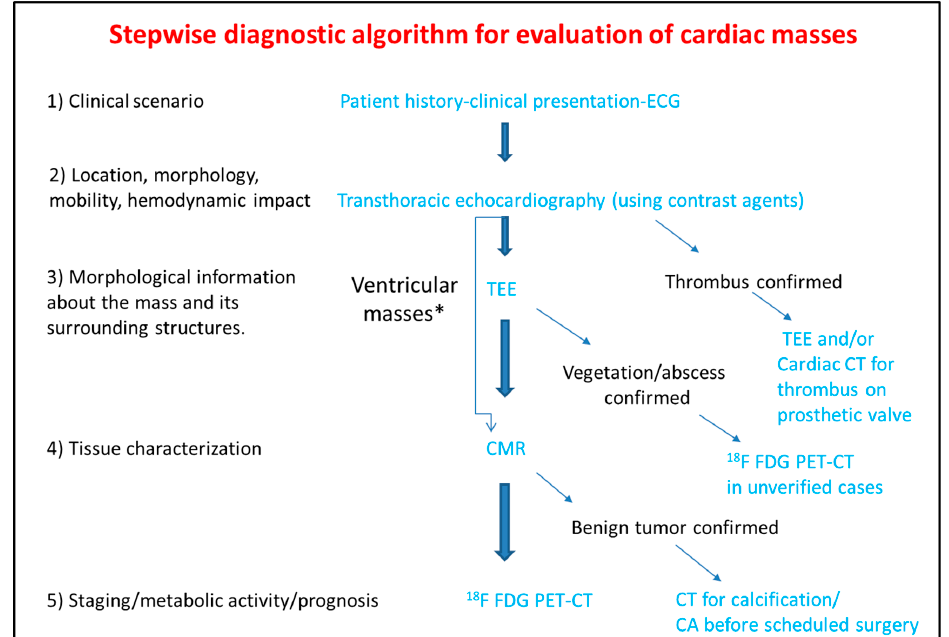
Figure 12. Step-by-step diagnostic algorithm for cardiac masses using cardiovascular imaging.